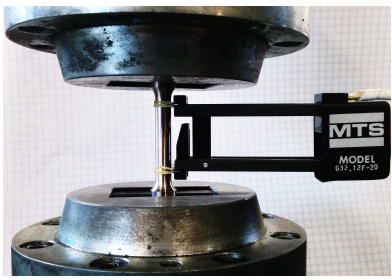
Figure 1. Picture taken during a tensile